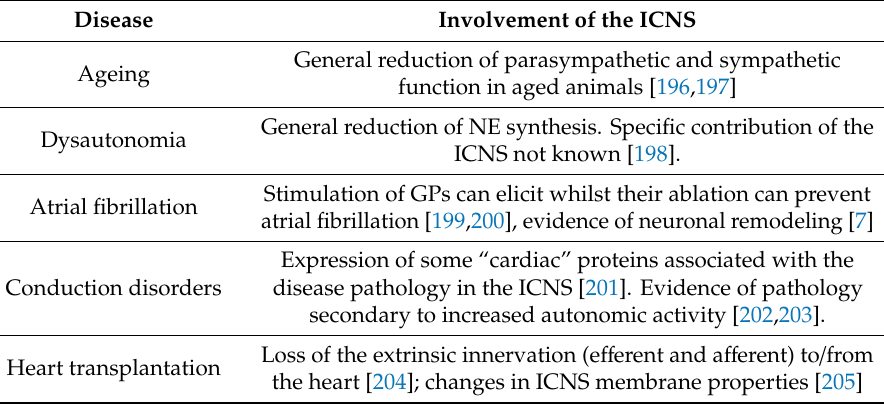
Table 1. Summary of the contribution of the ICNS in some cardiac